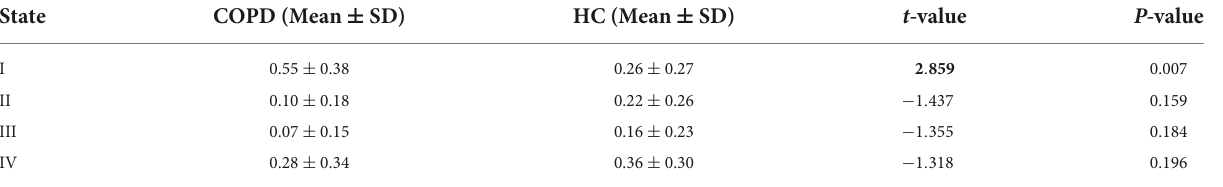
TABLE 4 Two sample t -tests of fractional windows between the patients with COPD and